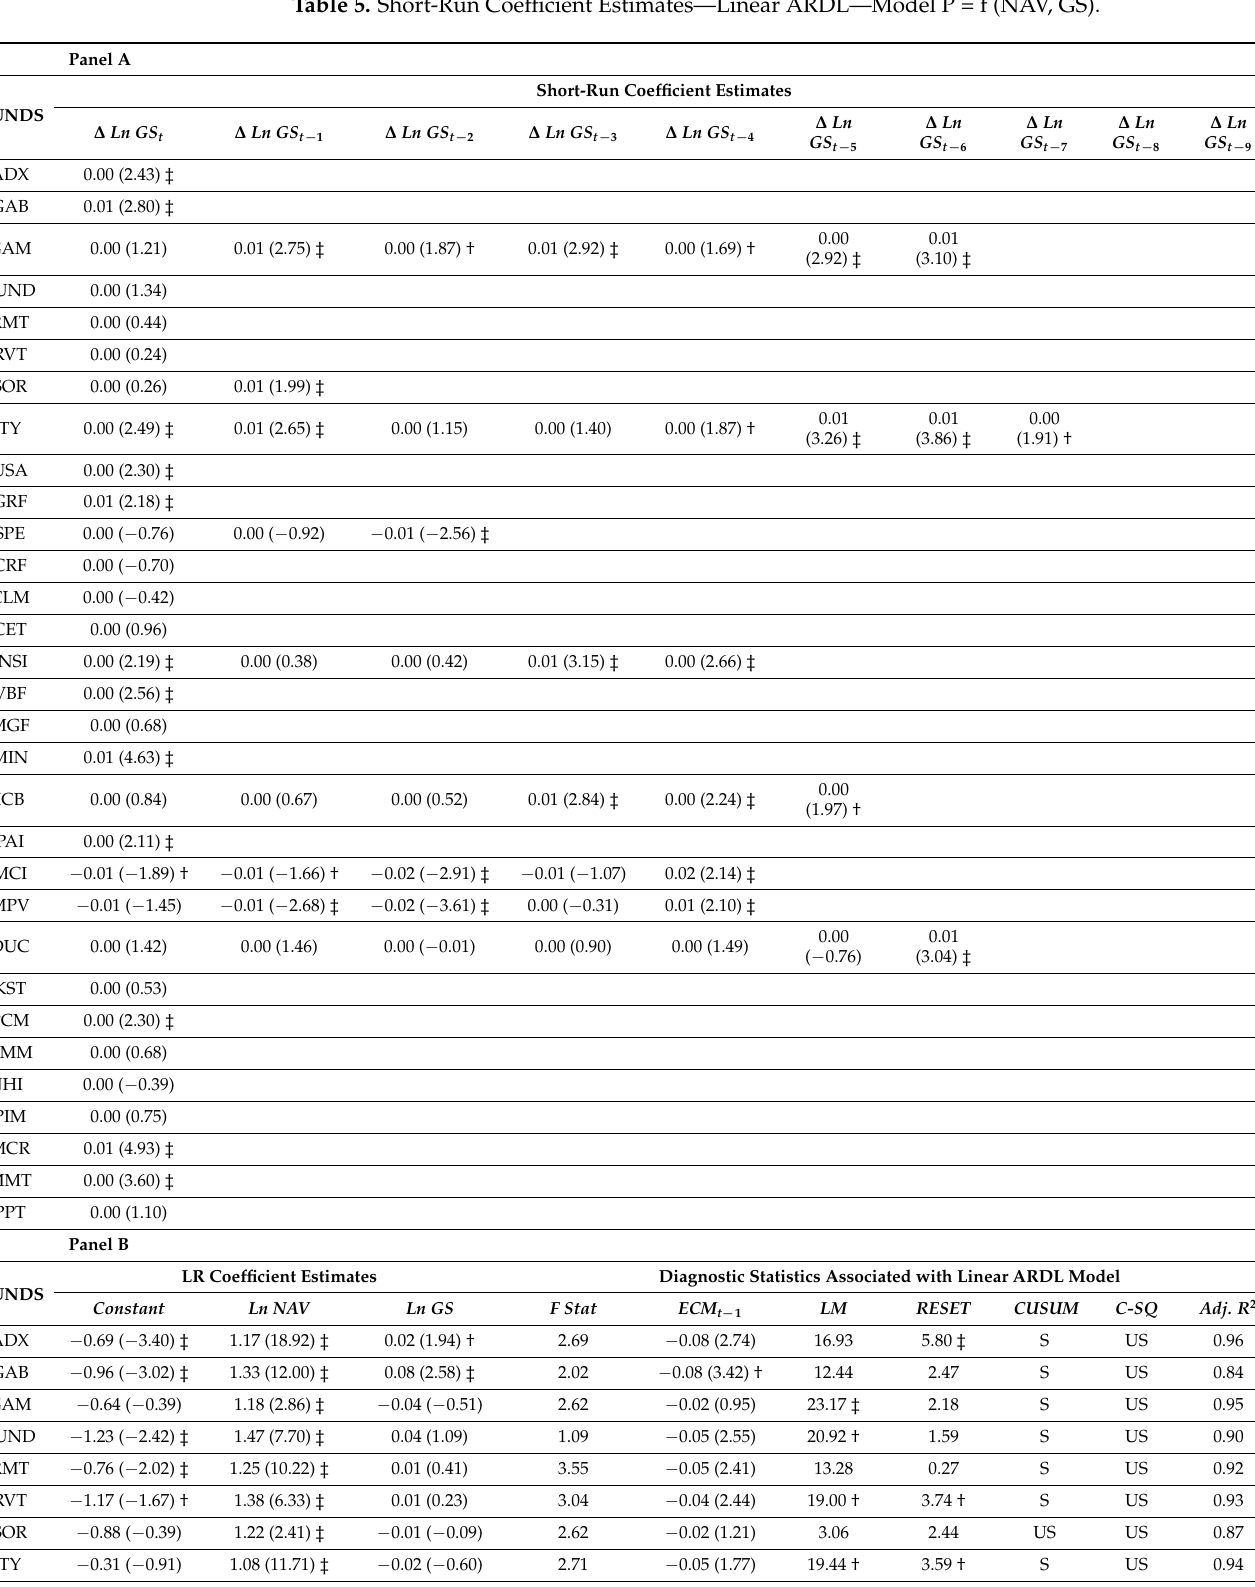
Table 5. Short-Run Coefficient Estimates—Linear ARDL—Model P = f (NAV,